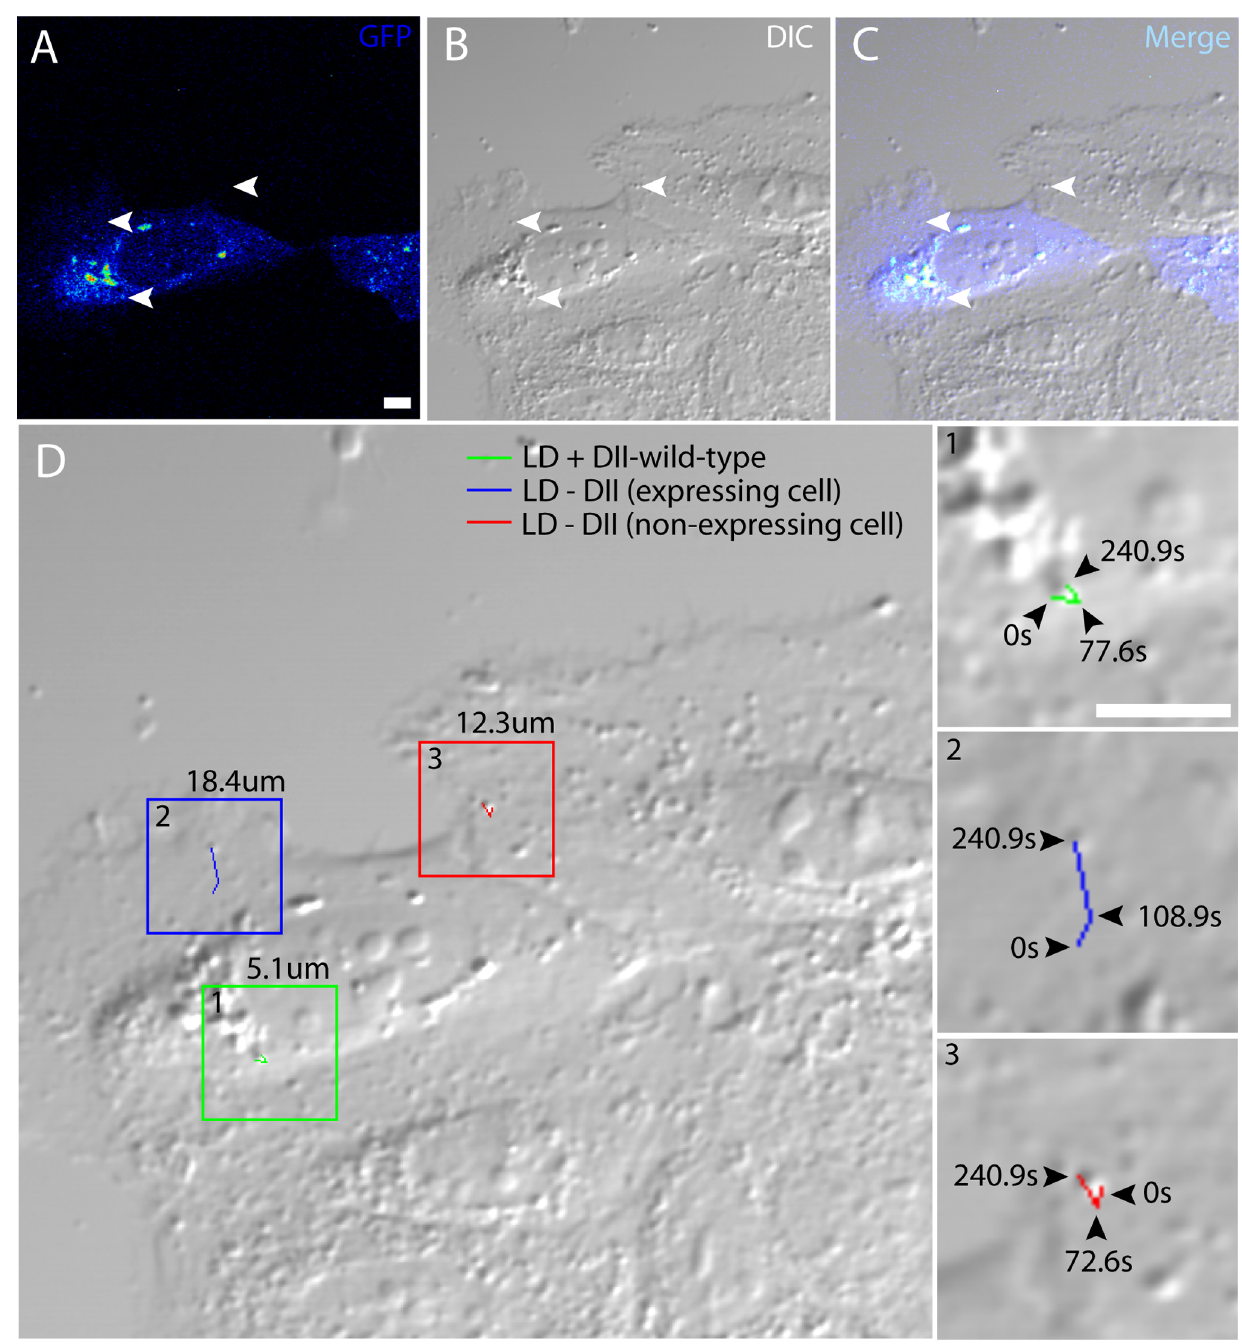
Figure 2. DII-core wt coated LDs are particle tracked using simultaneous TPF and DIC microscopy. This is a representative image of DII- core wt expressed in Huh-7 cells. Three individual LDs with dissimilar environments were selected (A–C, white arrows), and their trajectories were measured to calculate the overall distances traveled. (D) A larger DIC image of (B) includes boxes to identify each LD trajectory (inset 1–3). The value above each box (D) indicates their overall travel distances for (1) DII-core wt coated LD, (2) non DII-core wt coated LD within the same cell, (3) and a LD in an adjacent cell not expressing DII-core wt . Each LD trajectory is magnified to demonstrate the LD track with selective freeze frame time-intervals representing the LD position at their indicated times. Due to frequent bidirectional movements, the displayed trajectories represent a general movement path, and does not portray total distance. All of the LDs are tracked according to the same start and end time. All scale bars represent 10 m m. more frequently towards one direction, and thus, reveal differen- opposite directions, measured LD velocities can provide informa- tial activity between the two motors. The trajectories of individual tion about whether the mobility of DII-core wt coated LDs travel LDs were tracked using the center of the nucleus as a fixed point